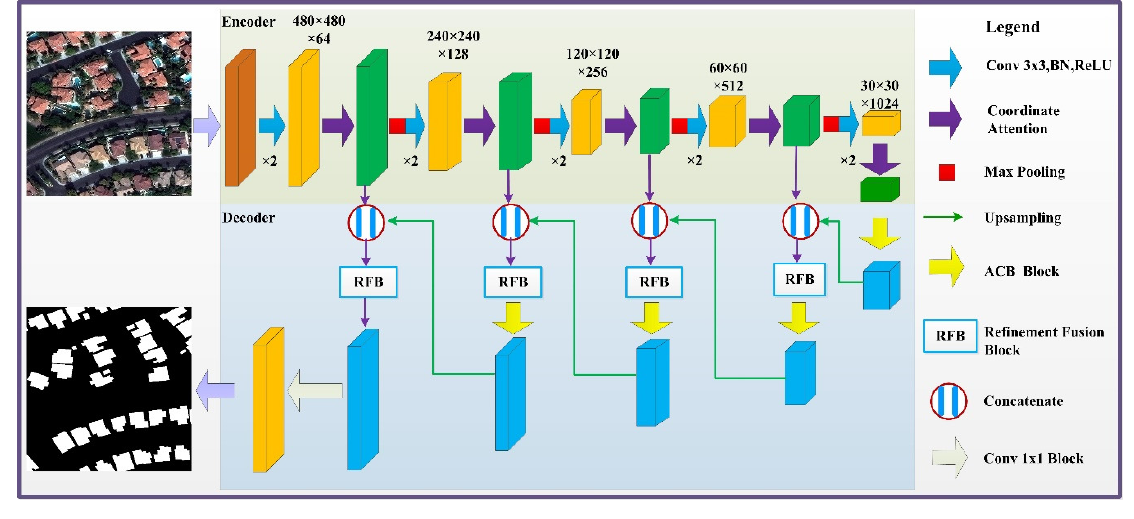
Figure 3. The FCAU-general Net’s architecture.